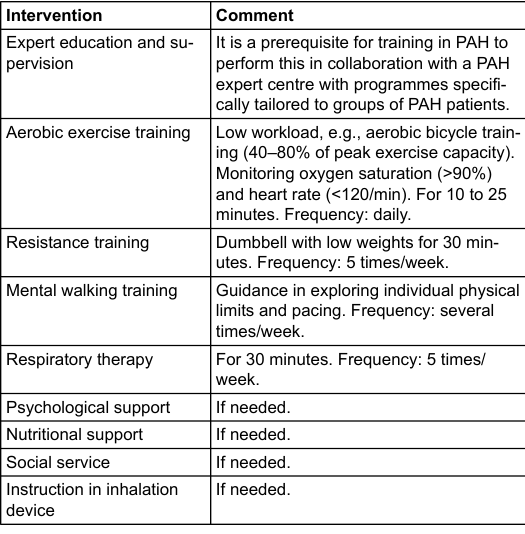
Table 1: Different components of the rehabilitation programme in pa- tients with pulmonary arterial hypertension (PAH). Intervention